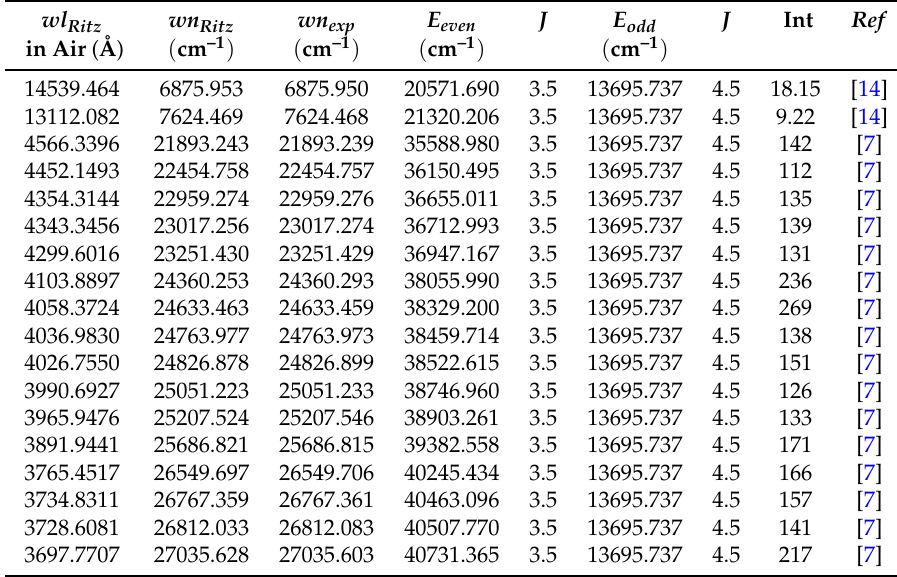
Table 4. Transitions of the U II odd parity level at 13695.737 cm − 1 with J = 4.5 to even levels of J =